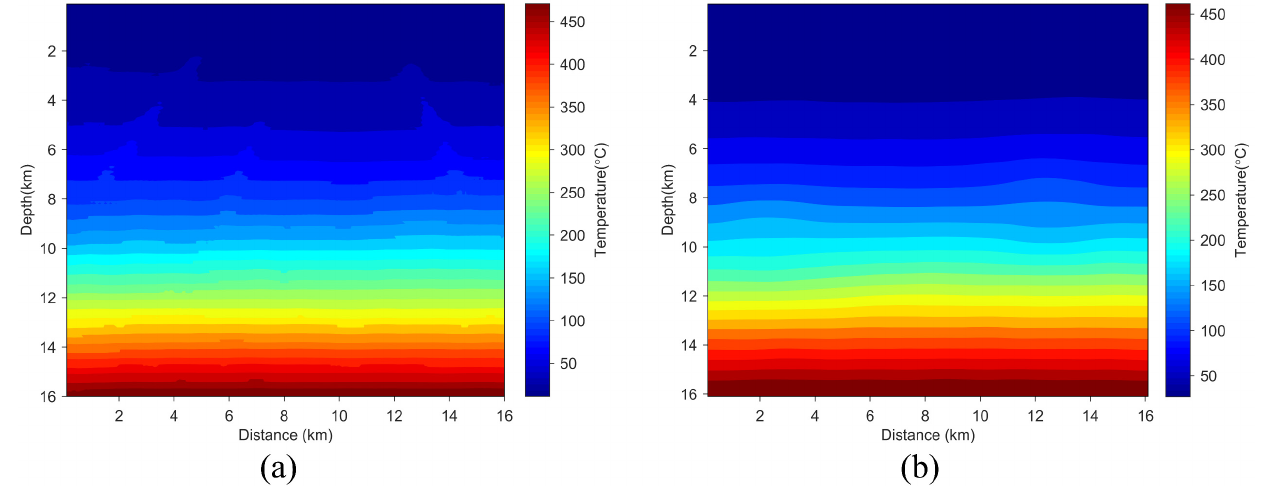
Figure 10. Temperature simulation comparison of the first model. ( a ) Temperature field simulated by the HDRT–UNet; ( b ) Temperature field simulated by the finite element method.